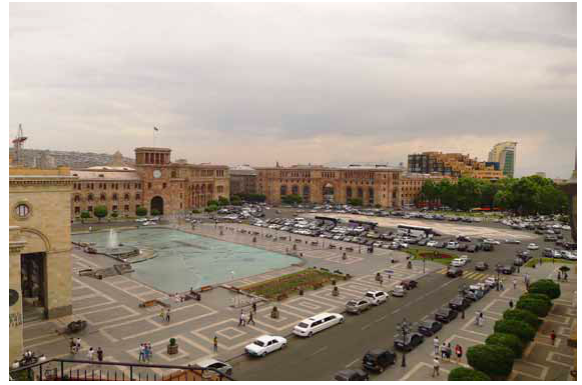
fig. 16. republic (formerly lenin) Square in Yerevan. r. Čepai- tienė photo